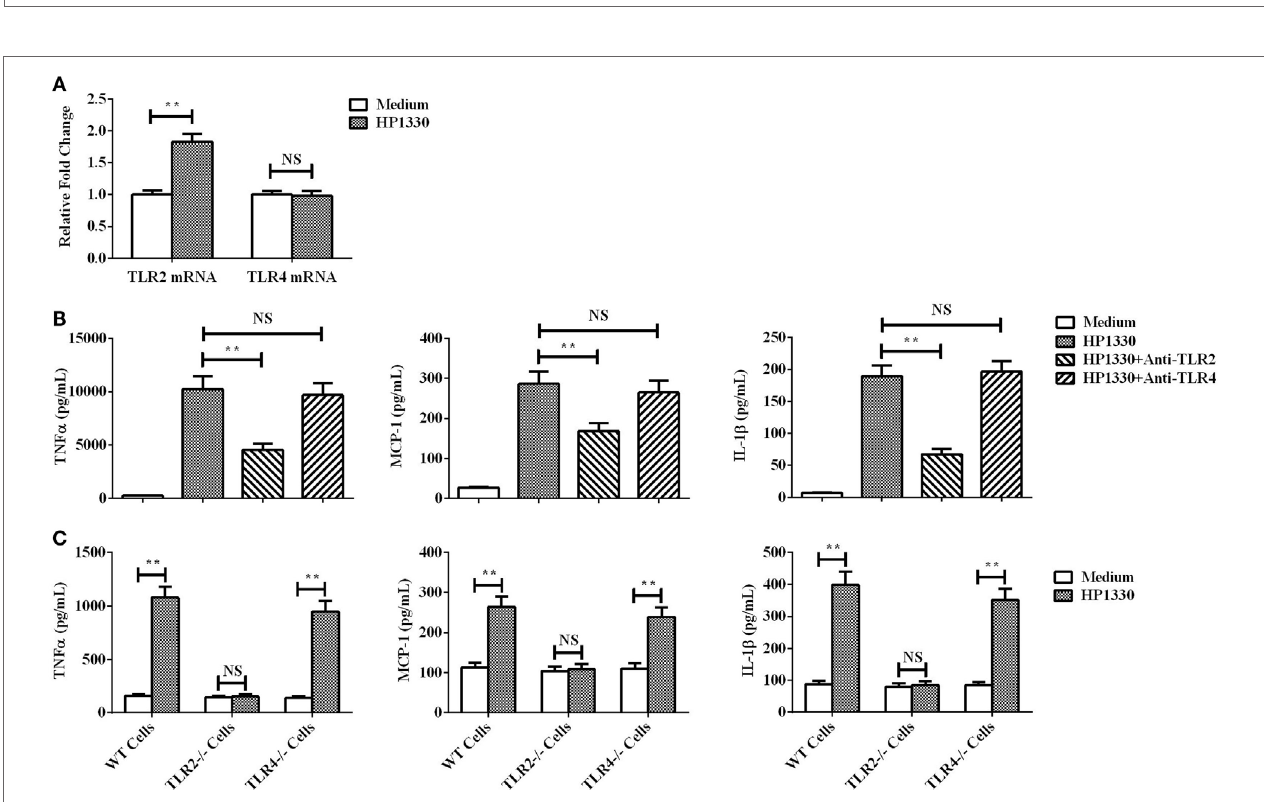
FigUre 8 | Recognition receptor of the HP1330-stimulated pro-inflammatory response. (a) After stimulation with HP1330, RAW264.7 cells were collected to analyze the mRNA levels of toll-like receptor 2 (TLR2) or TLR4 by qRT-PCR. (b) Antibody blocking assays. After pretreatment with 8 µg of an anti-TLR2 or anti-TLR4 antibody for 30 min, RAW 264.7 cells were incubated with 10 µg ⋅ ml − 1 HP1330 for 6 h. The concentrations of TNF- α , MCP-1, and IL-1 β were determined by enzyme-linked immunosorbent assay (ELISA). (c) Primary peritoneal macrophages were isolated from TLR2 − / − , TLR4 − / − , and wild-type (WT) mice, after which they were incubated with 10 µg ⋅ ml − 1 HP1330 for 6 h. The cytokine concentrations in the supernatants were determined by ELISA. The error bars represent the SEMs, based on three independent experiments. ** P <